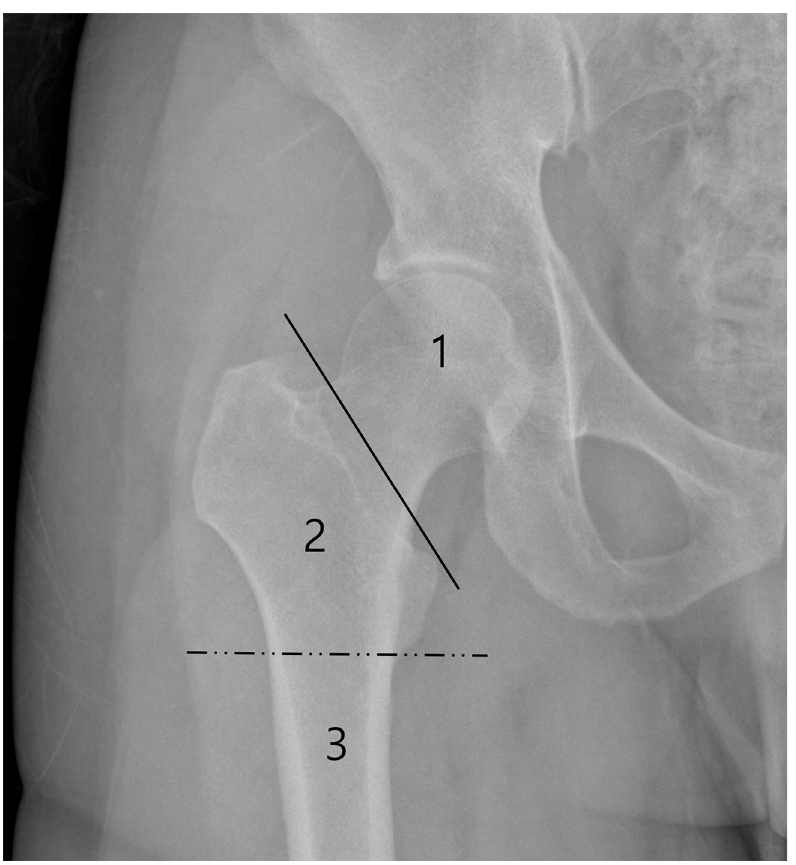
Fig 1. The field of view (FOV) of the 3D-MRI. The unilateral hip joint was covered by a 230 × 230 mm FOV in the coronal plane. The proximal femur was divided into epi-metaphyseal (area 1: femoral head and neck area), metaphysis (area 2: intertrochanteric area), and diaphysis areas (area 3: femoral shaft area).